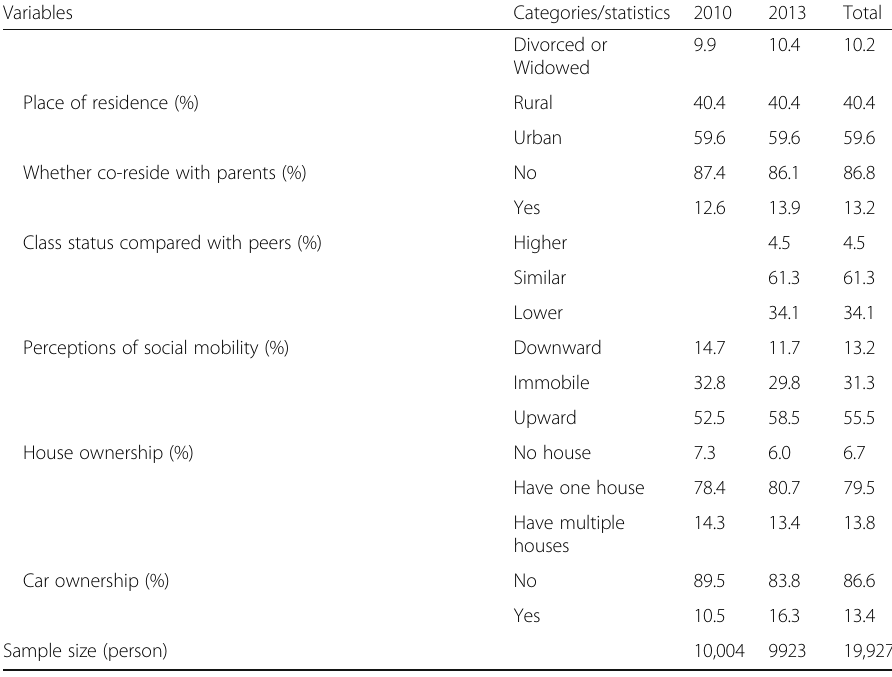
Table 2 Descriptive statistics for each variable (Continued)